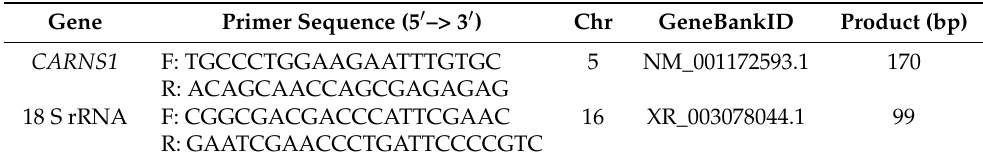
Table 2. Gene and primer sequences used for qRT-PCR.